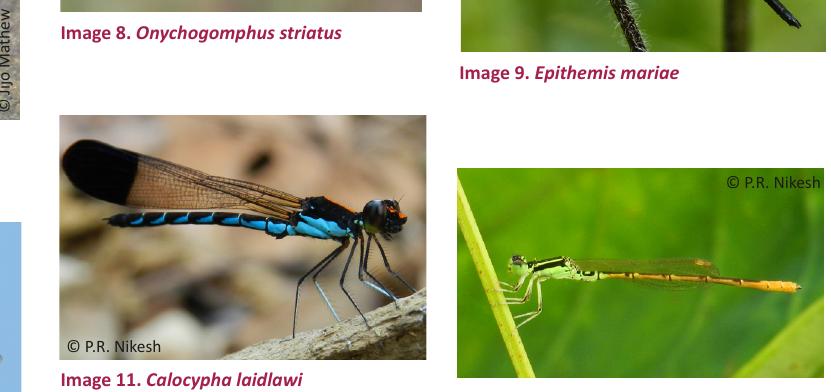
Image 12. Agriocnemis keralensis